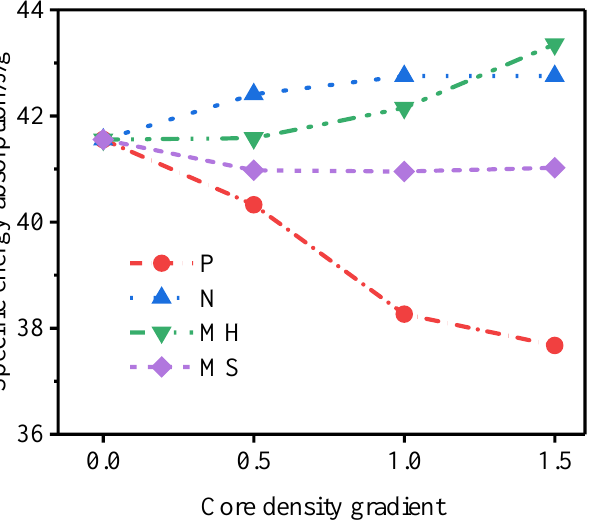
Figure 18. The influence of different core density gradients on the deformation of the outer tube.